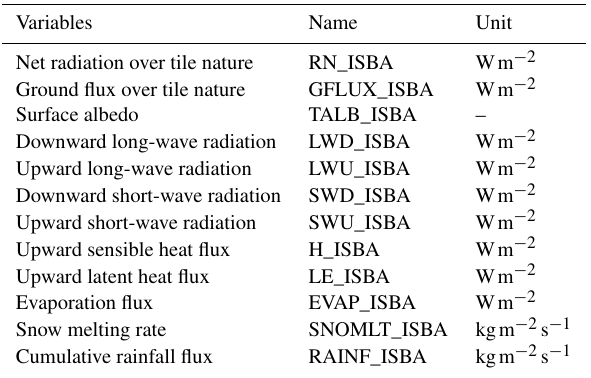
Table 5. List of variables integrated over the past 24h at 06:00UTC.